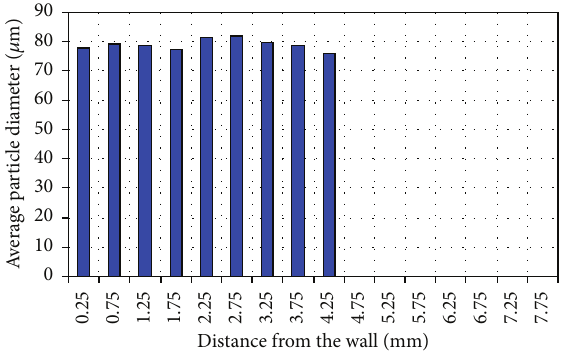
Figure 11: Distribution of the average particle diameter of the one- side reinforced disc.